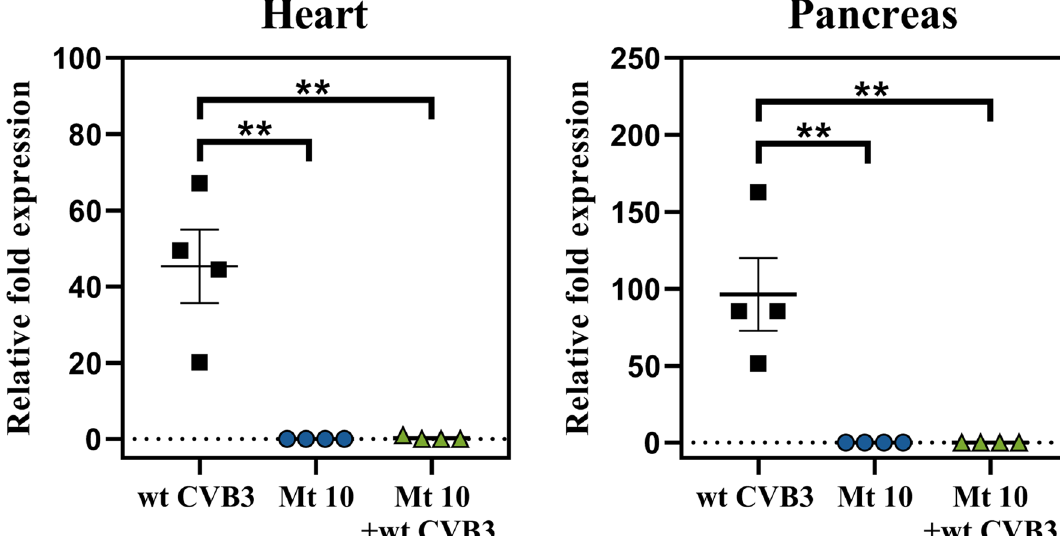
Figure 9. Recipients of Mt 10 virus challenged with the wt CVB3 virus did not reveal viral RNA. Groups of mice were administered saline or Mt 10 virus, and 14 days later, they were challenged with or without wt CVB3. Three weeks post-challenge, hearts and pancreata were collected, total RNA was extracted, and CVB3 RNA was estimated by quantitative PCR targeting VP1 sequences, as described in the methods section. After normalizing the expression levels viral RNA relative to GAPDH, 2 −(∆∆ C t) values were calculated. Mean ± SEM values representing 4 samples per group, each containing n = 3 to 5 mice, are shown. Mann–Whitney test was used to determine significance between groups. ** p ≤